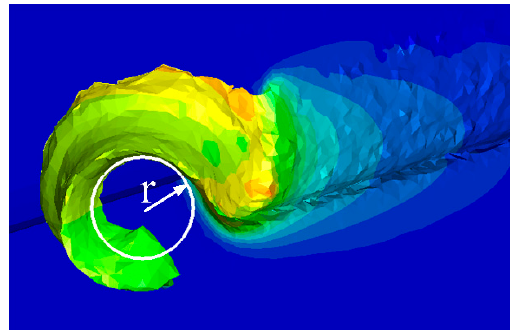
Figure 7. Measurement of the chip’s bending radius.